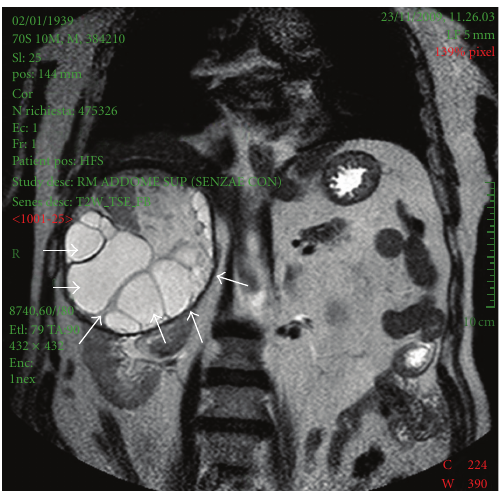
Figure 1: Magnetic resonance image showing the characteristic appearance of a hydatid cyst. Coronal T2 WI MRI shows marked hyperintensity with a hypointense rim (pericyst) of severaldaugther cysts that have less signal intensity than mother cyst.